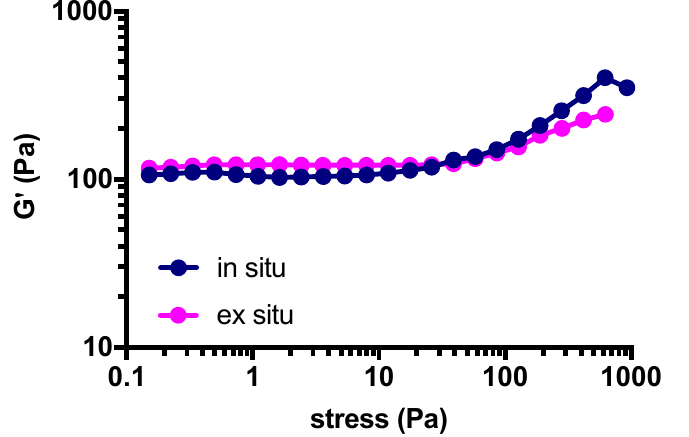
Figure 3. Sample-case dependence of the storage modulus ( G ′ ) as a function of stress for genipin- based chitosan hydrogels prepared on the rheometer (in situ, blue dots) or on plastic wells (ex situ, purple dots). In both cases, the polymer concentration was 1% (m/V), the genipin concentration was 0.31 mM, T = 60 °C and setting time 3 h.